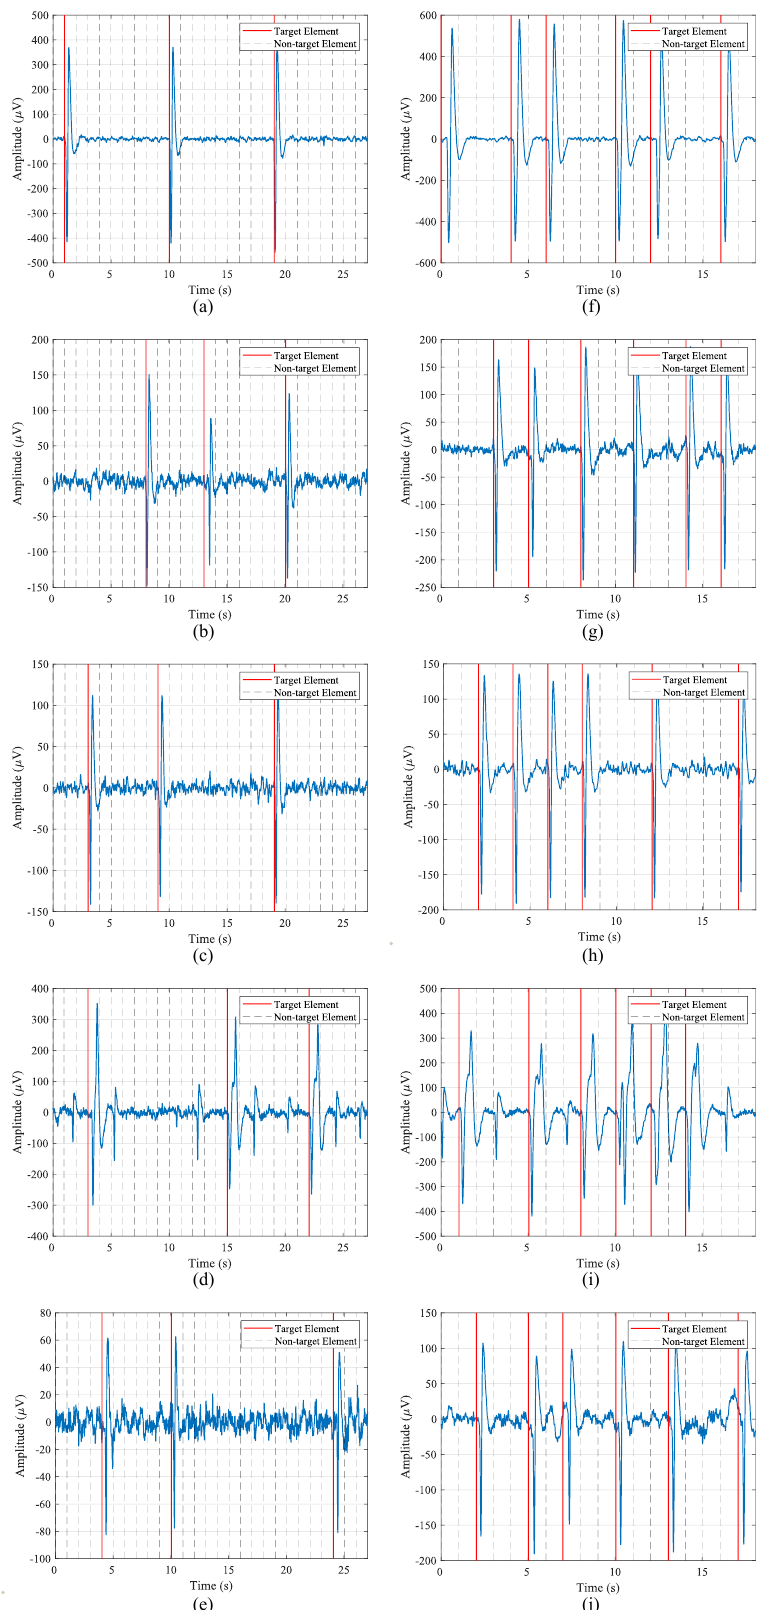
Figure 8. Data from the first five participants for one run of the blinking experiment for both stimulation paradigms: ( a – e ) 1-by-1 paradigm ; ( f – j ) row/column